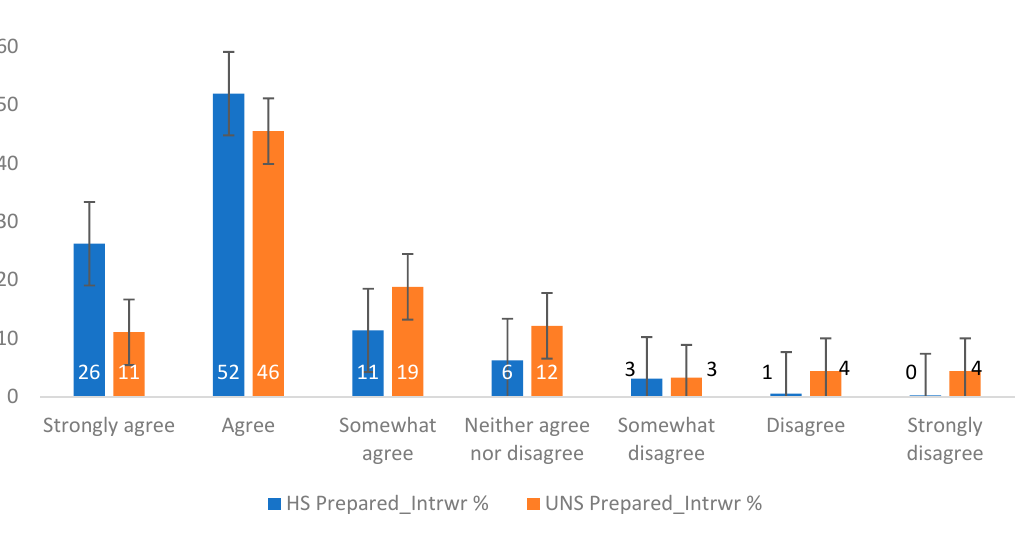
Figure 14. Interviewers prepared for interview.